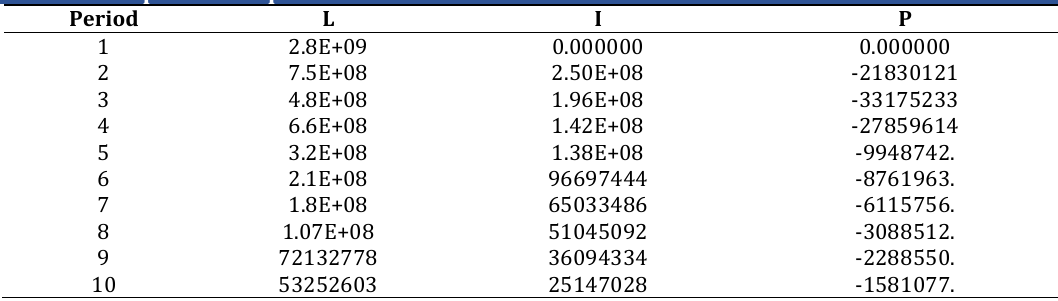
Table 4: Response of liquidities to one shock in variables